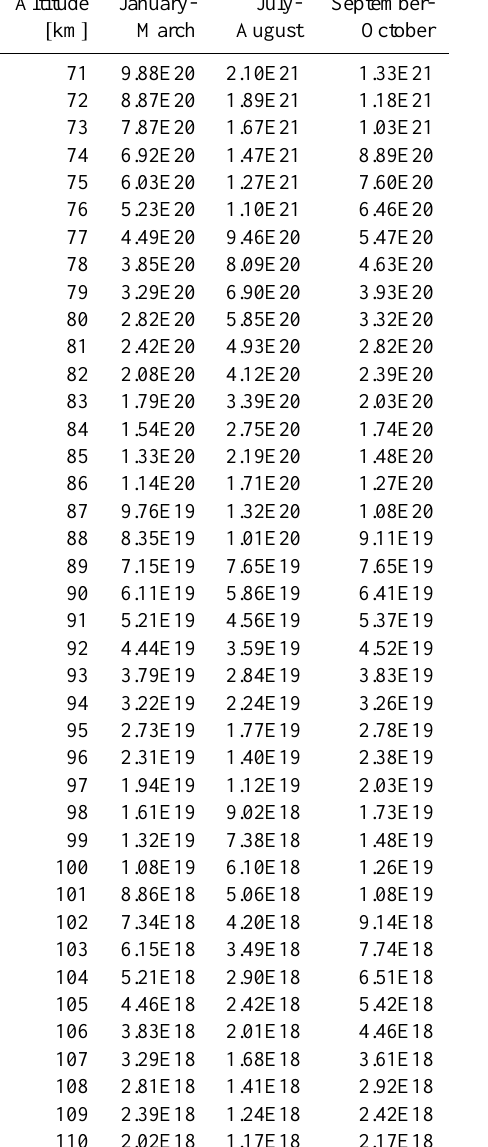
Table 5. Seasonal variation of ionization gauge neutral number den- sities. All densities are given in m − 3 . Read yEx as y · 10 x .